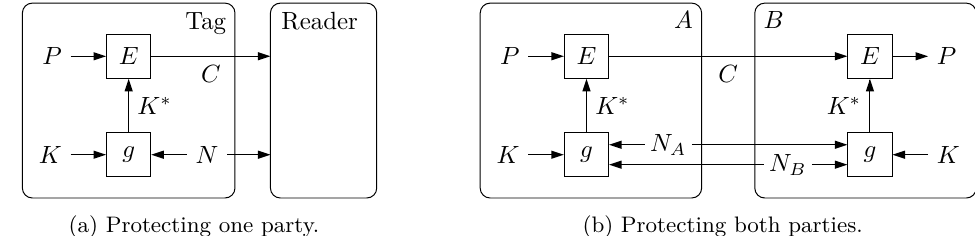
Figure 1: Re-keying of block